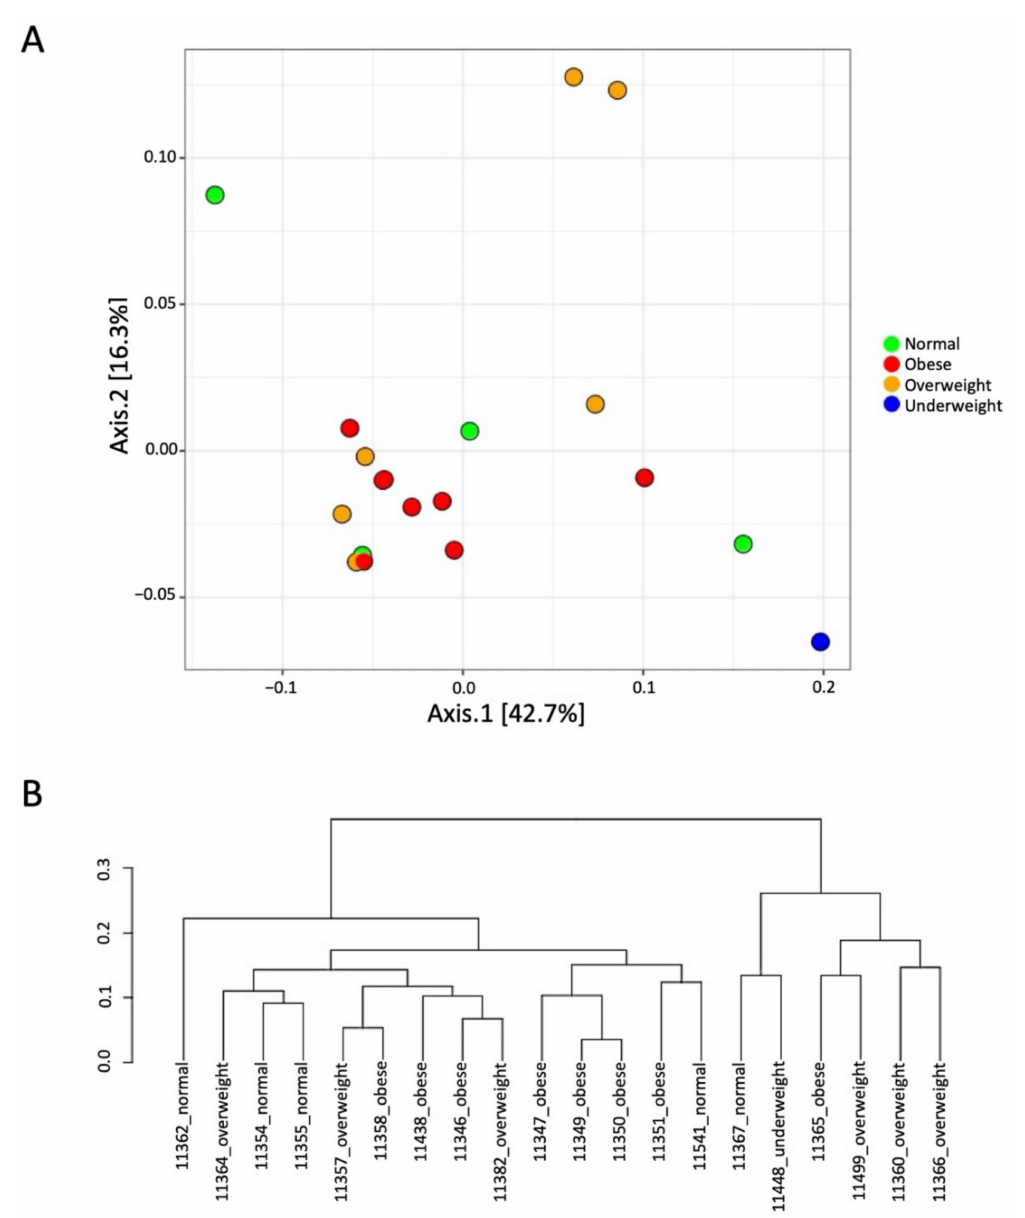
Figure 2. Beta diversity based on unweighted UniFrac measurements. ( A ) Principal coordinate analysis scatter plot showing the distribution of samples based on the microbiome composition; ( B ) dendrogram showing the clustering pattern of samples with varying